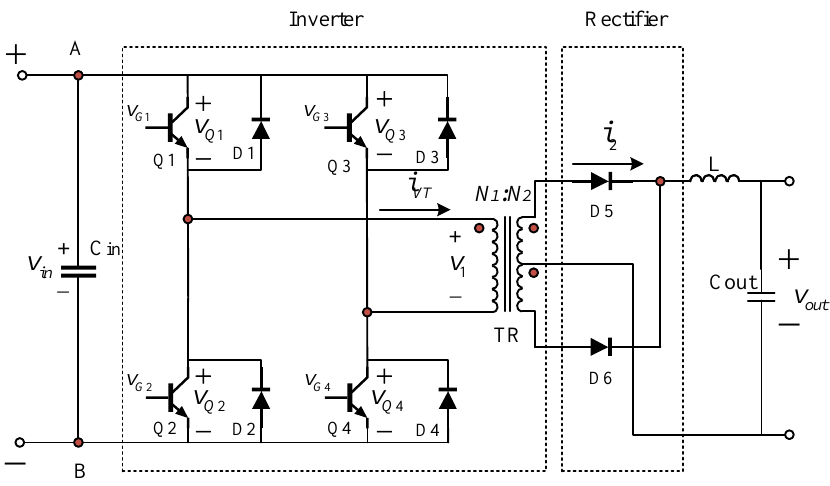
Figure 1. The single-phase full-bridge DC-DC converter with a transformer center-tapped rectifier.